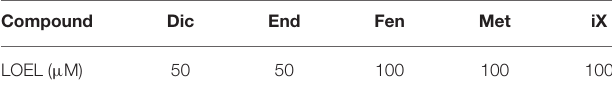
TABLE 3 | Onset of cytotoxicity (lowest observed effect level) of toxic single compounds, as observed in at least three independent SRB assays.